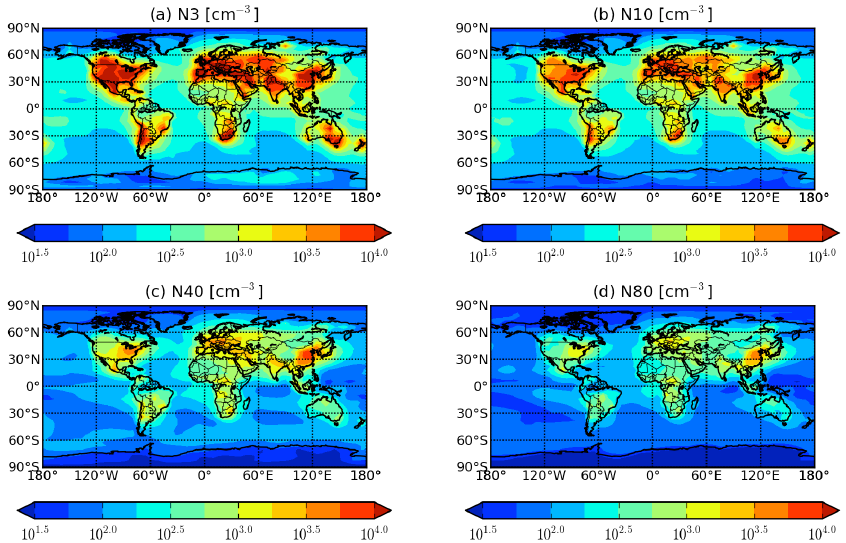
Figure 2. Global annual-mean boundary-layer total number of particles (a) N3, (b) N10, (c) N40 and (d) N80 (the total number of particles with diameter larger than 3 nm, 10 nm, 40 nm and 80 nm respectively) for the MASS-BASE case.